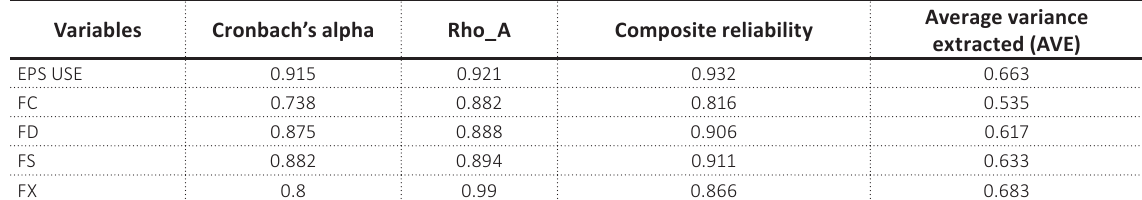
Table 3. Construct reliability and validity